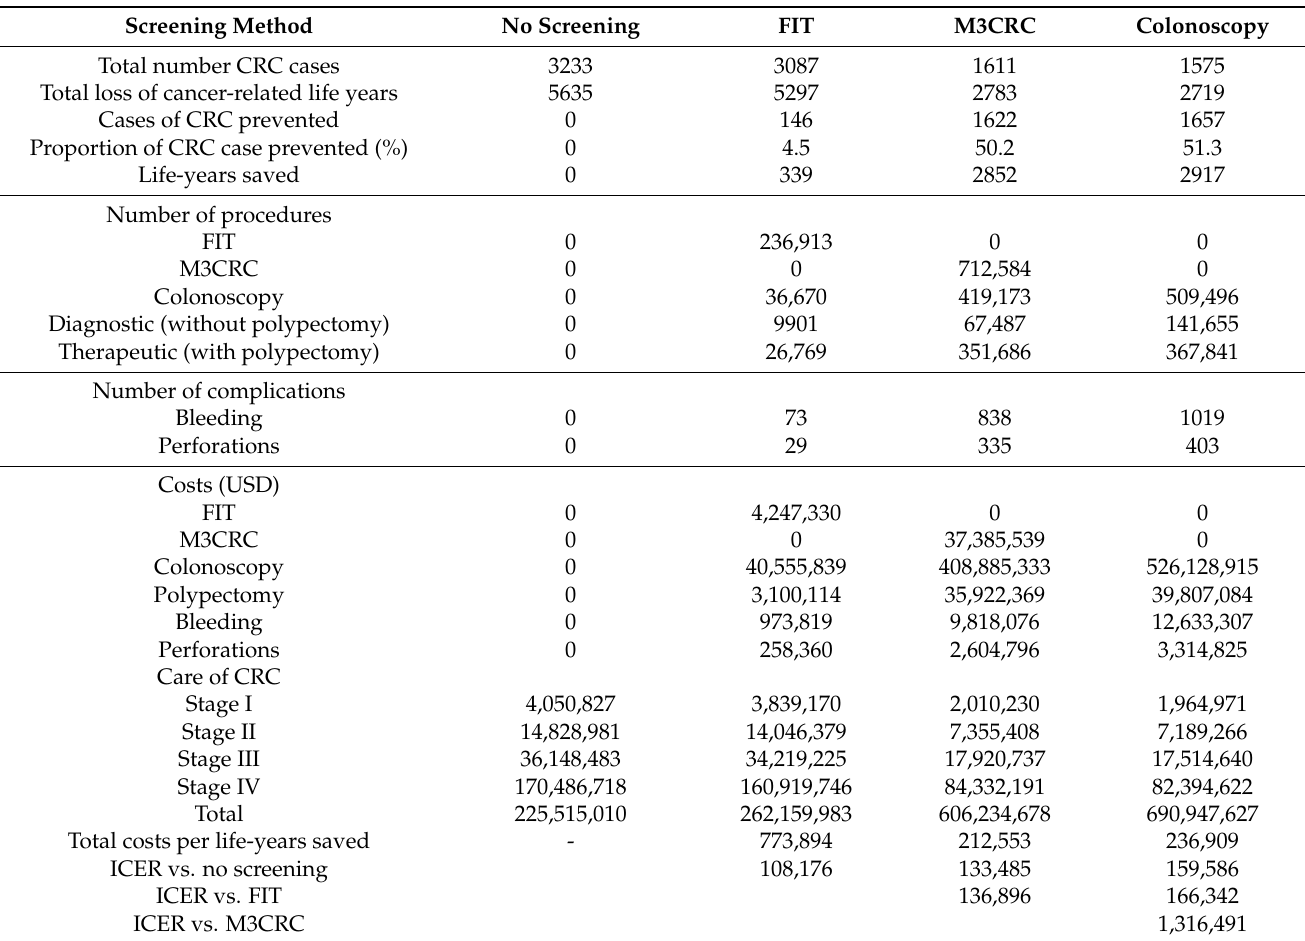
Table 3. Result of 100,000 average-risk individuals aged 50–75 years with FIT, M3CRC, colonoscopy, and no screening for colorectal